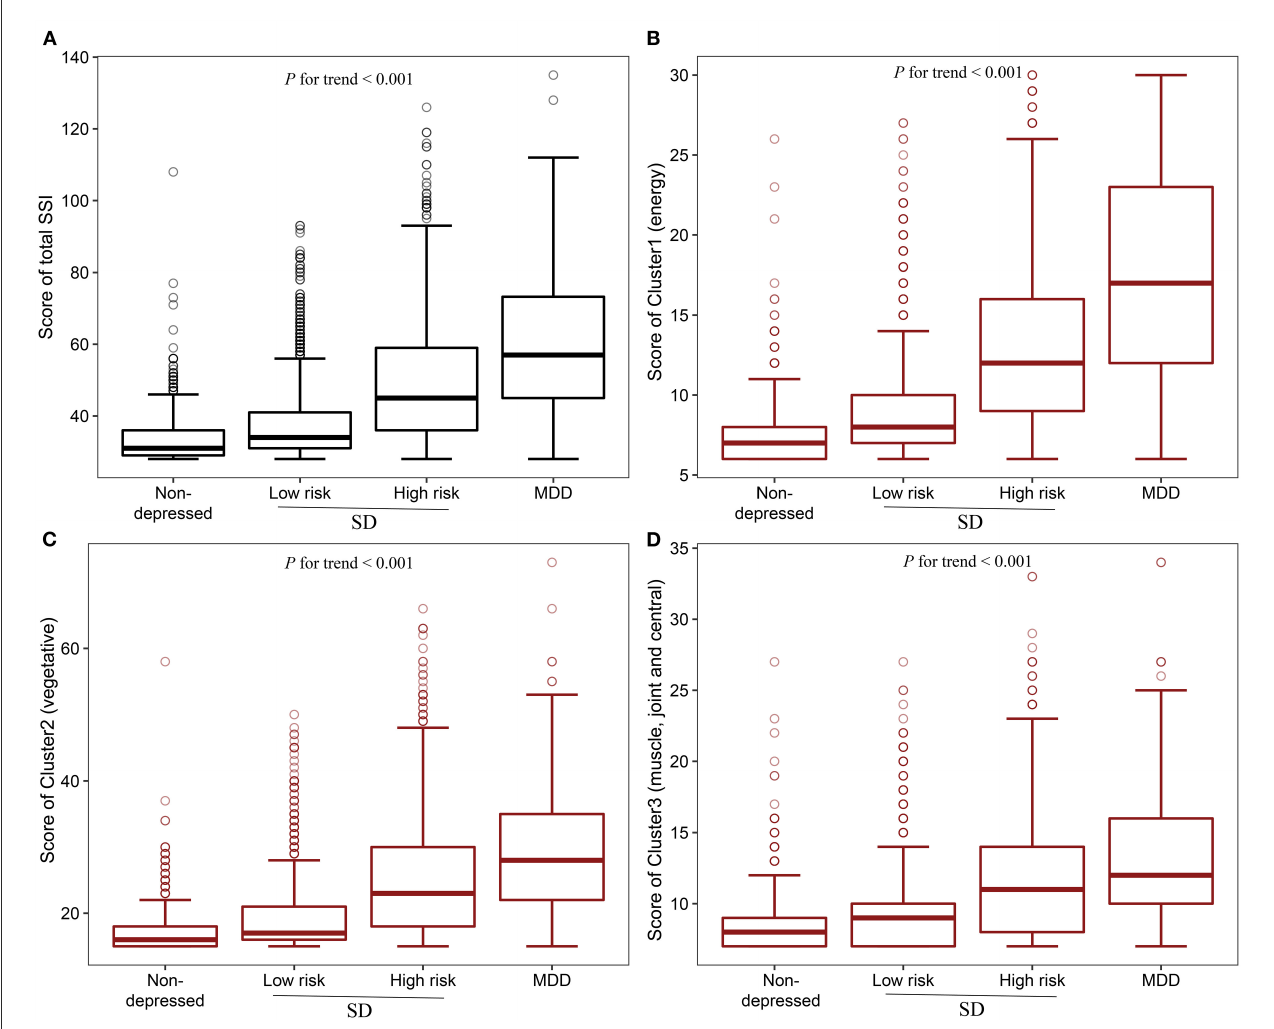
FIGURE2 Boxplot of Total SSI score and different clusters scores. (A) Total SSI score in different groups; (B) Cluster 1(energy-related symptoms) score in different groups; (C) Cluster 2 (vegetative symptoms) score in different groups; (D) Cluster 3 (muscle, joint and central nervous symptoms) score in different groups. P for trend was determined by General linear model (GLM) evaluating the linear trend of the different clusters of somatic symptoms from non-depressed individuals to SD, and to MDD after adjustment for age, gender, marital status, education, employed status, family income, living status, chronic disease, smoking frequency, drinking frequency, BMI, exercise frequency, sleep duration, and sleep quality. SD, subthreshold depression; MDD, major depressive disorder; SSI, somatic symptoms